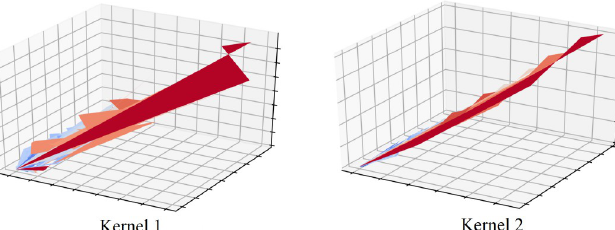
Fig 6. Kernel output comparison of 1D CNN